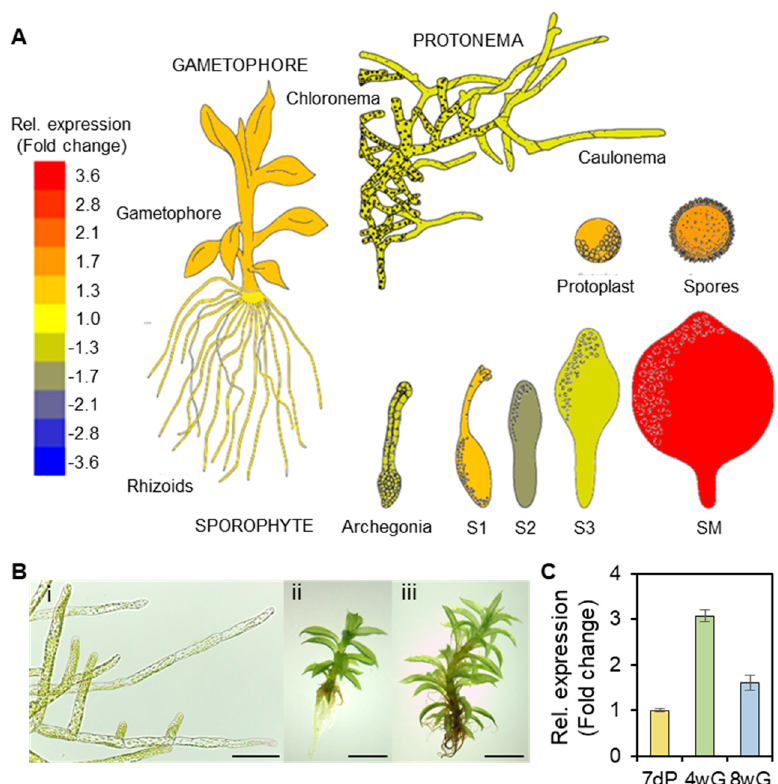
Figure 2. Expression pattern of PpGPAT9 in P. patens . ( A ) The expression of PpGPAT9 ( Pp1s138_27V6.1 , Phpat.011G104300 ) relative to PpActin2 ( Pp1s198_157V6.1 , Phpat.003G133100 ). Images and values were obtained from P. patens eFP-Browser (http://bar.utoronto.ca/efp_physcomitrella/cgi-bin/efpWeb.cgi). Three- to 4-week-old gametophore;